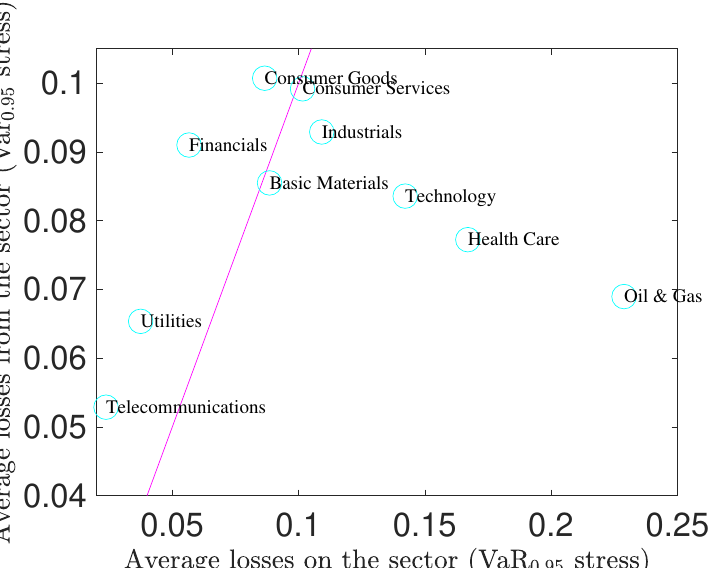
Figure 3. Average losses caused on the entire system by stressing a given sector to 95% of its VaR vs. the losses on the sector when the rest of the system is stressed to 95% VaR. The line is the diagonal separation and is reported for visual